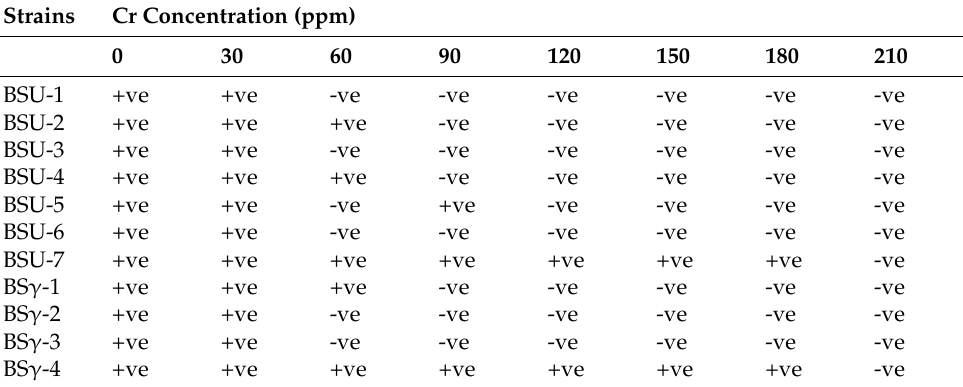
Table 2. Minimum inhibitory concentration of isolates for Cr stress